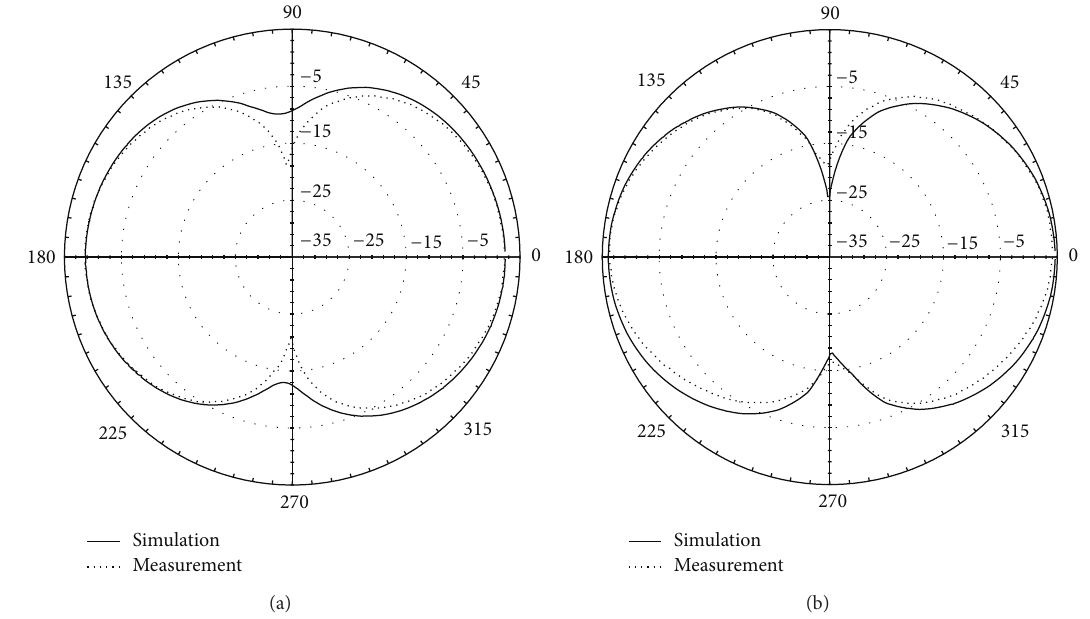
Figure 4: Simulated and measured radiation patterns of the reference antennas ( xz -plane); (a) the monopole antenna and (b) the slot antenna.